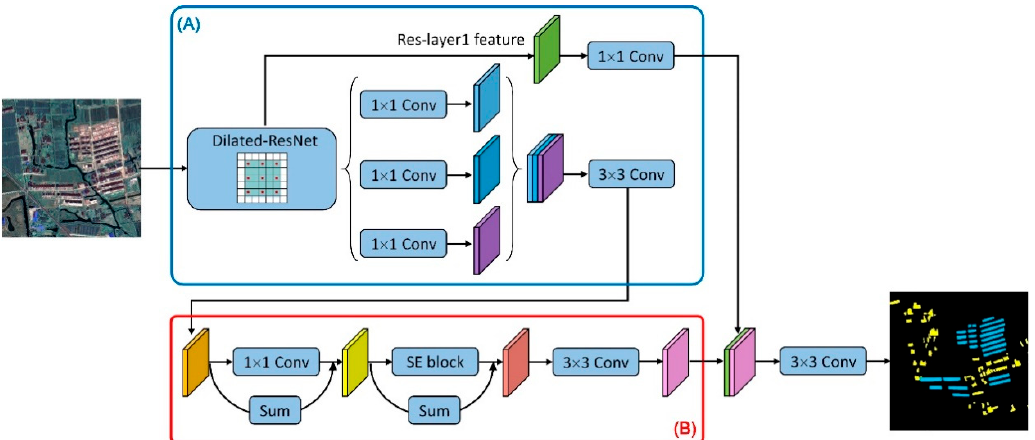
Figure 3. Overview of the proposed detection architecture. ( A ) the Dilated-ResNet extracted multi-level features with high spatial resolution; ( B ) the context subnetwork exploited the multi-scale context and mapped features to desired outputs.